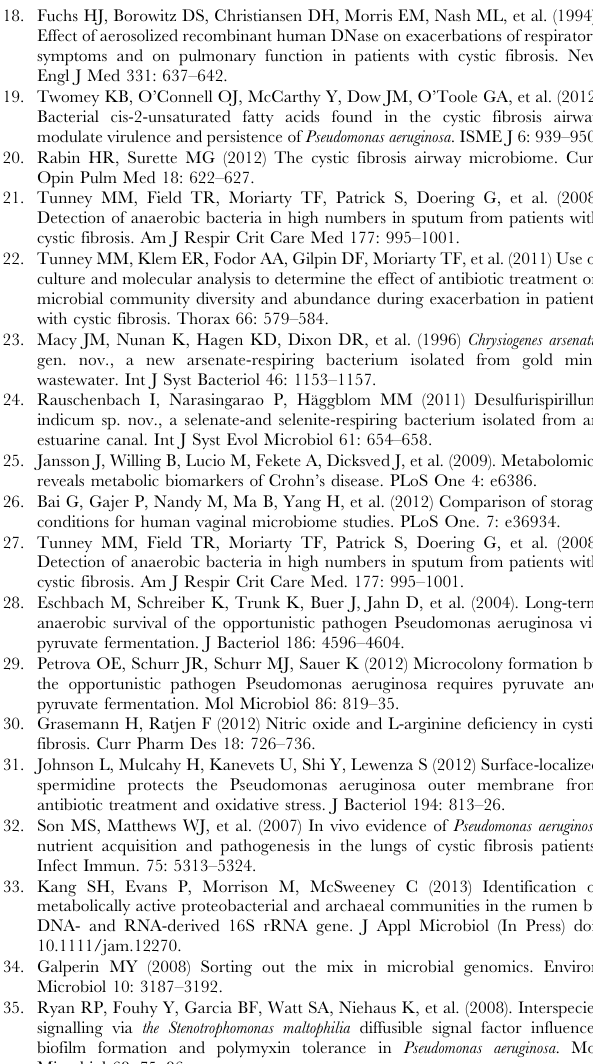
circles represent stable samples while the red diamonds represent samples from patients suffering exacerbation. Table S1 Clinical data associated with CF and non-CF patients included in this study. Table S2 Sampling depth and biodiversity found by bar-coded 454 sequencing of sputum samples from the three patient cohorts. Table S3 Microorganisms recovered from sputum taken from three patient cohorts included in the study. (PDF) Table S4 Concentrations of metabolites identified in CF sputum taken from 26 stable CF patients. Data are given as the average values measured in triplicate (metabolite concentra- tions are described as m M unless otherwise stated and means 6 standard deviations are reported).